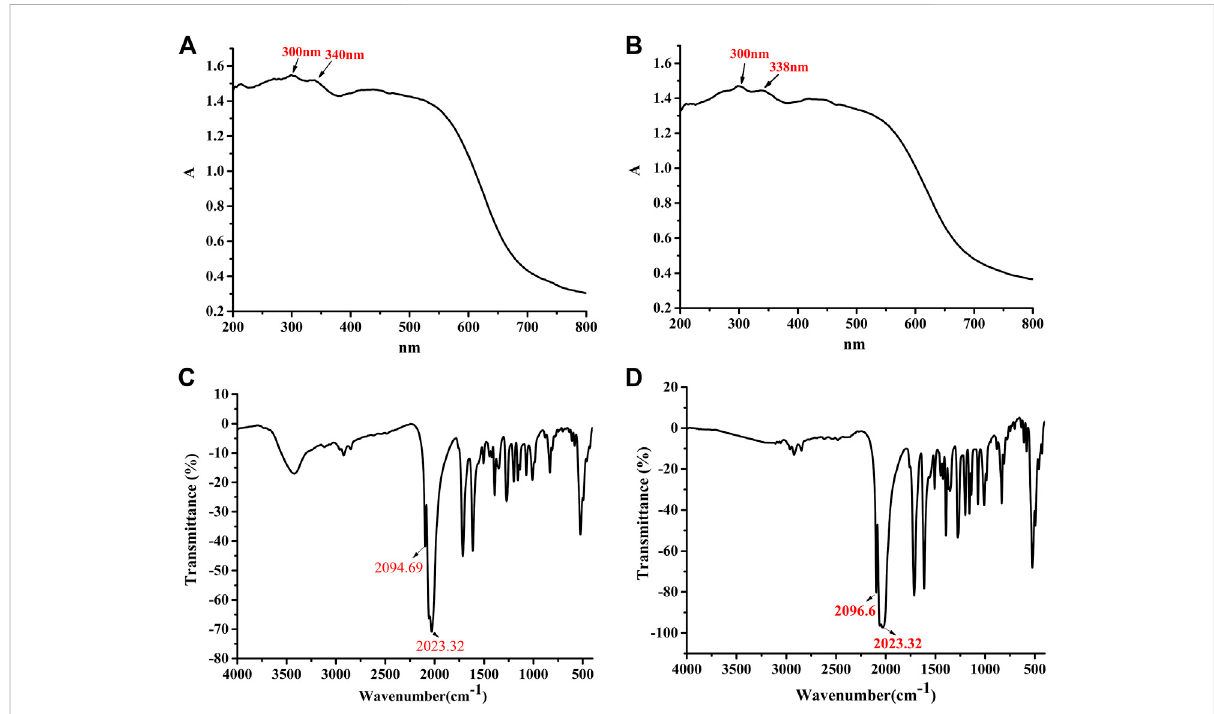
FIGURE 2 The UV spectrum of complex 5 after exposed to the air for 7 d. [0 d (A) , 7 d (B) ]. The Infrared spectrum of complex 5 after exposed to the air for 7 d. [0 d (C) , 7 d (D)